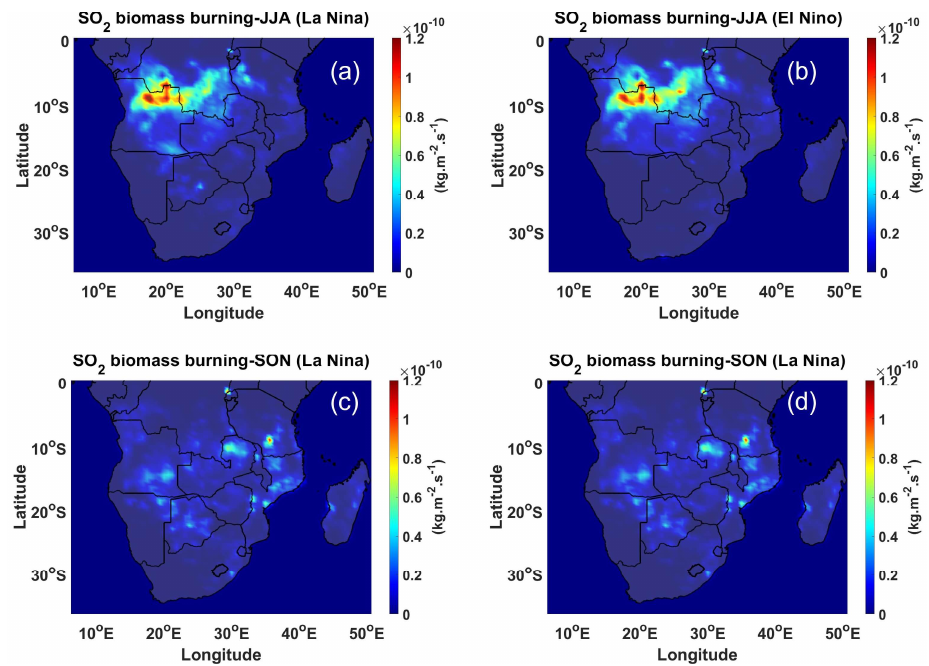
Figure 6. Spatial distribution of SO 2 biomass-burning emissions for the JJA ( a , b ) and SON ( c , d ) sea- sons during the La Niña ( a , c ) and El Niño ( b , d ) events.